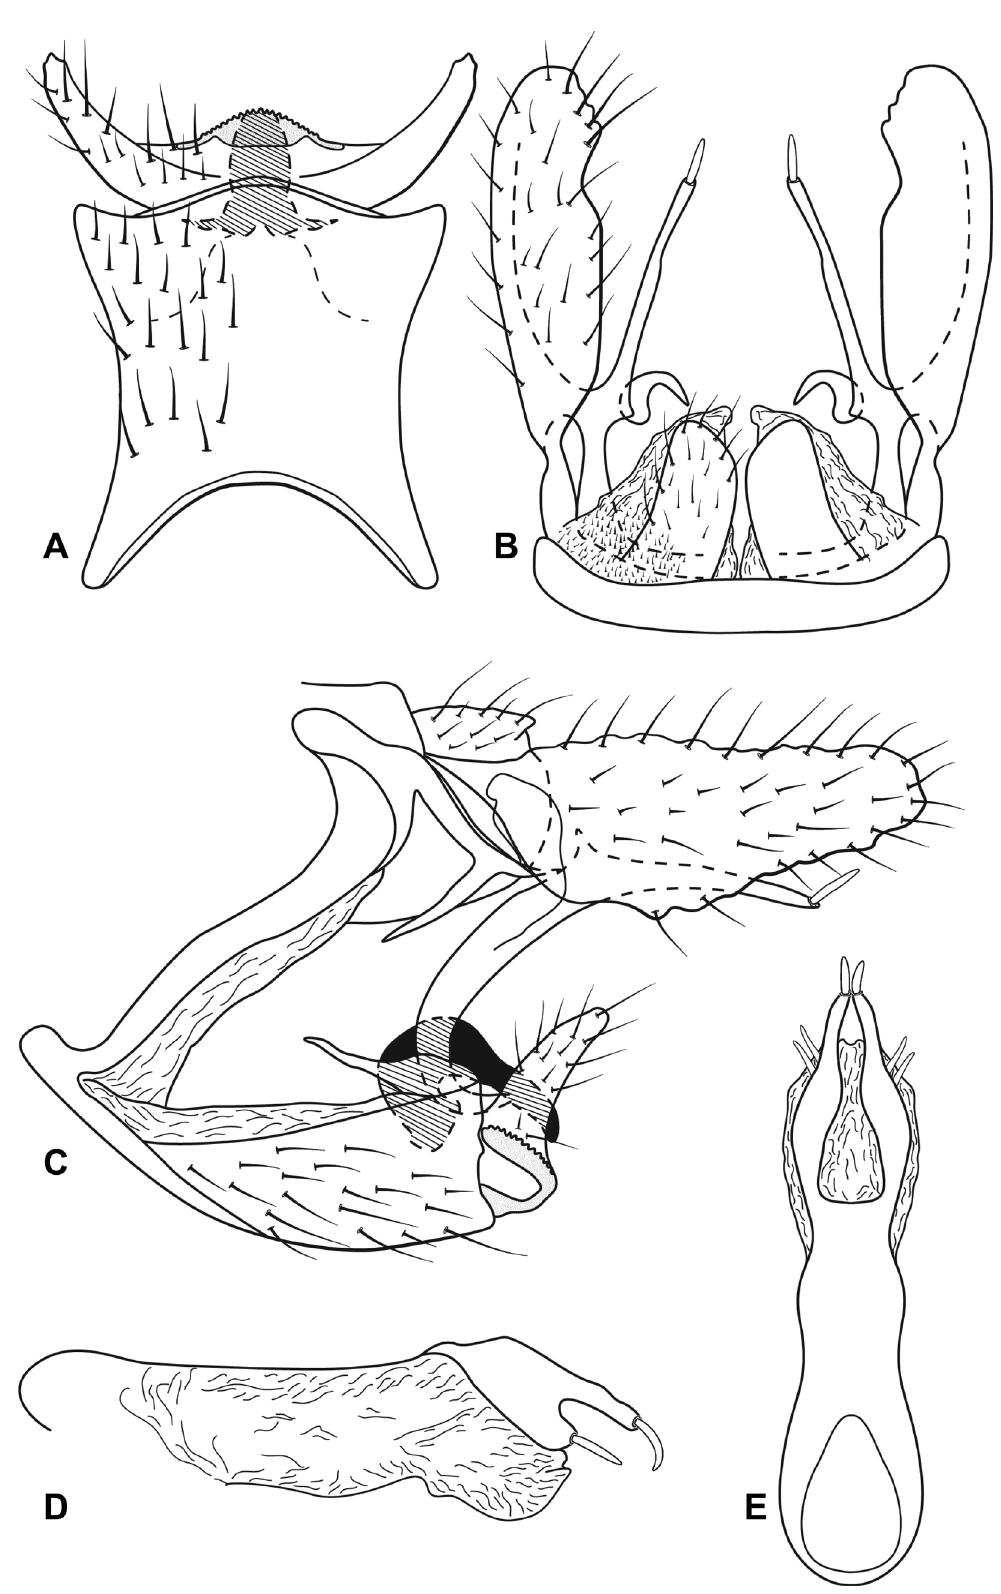
Fig. 6. Austrotinodes cruzi sp. nov., male genitalia. A . Ventral view. B . Dorsal view. C . Left lateral view. D . Phallic apparatus, left lateral view. E . Phallic apparatus,